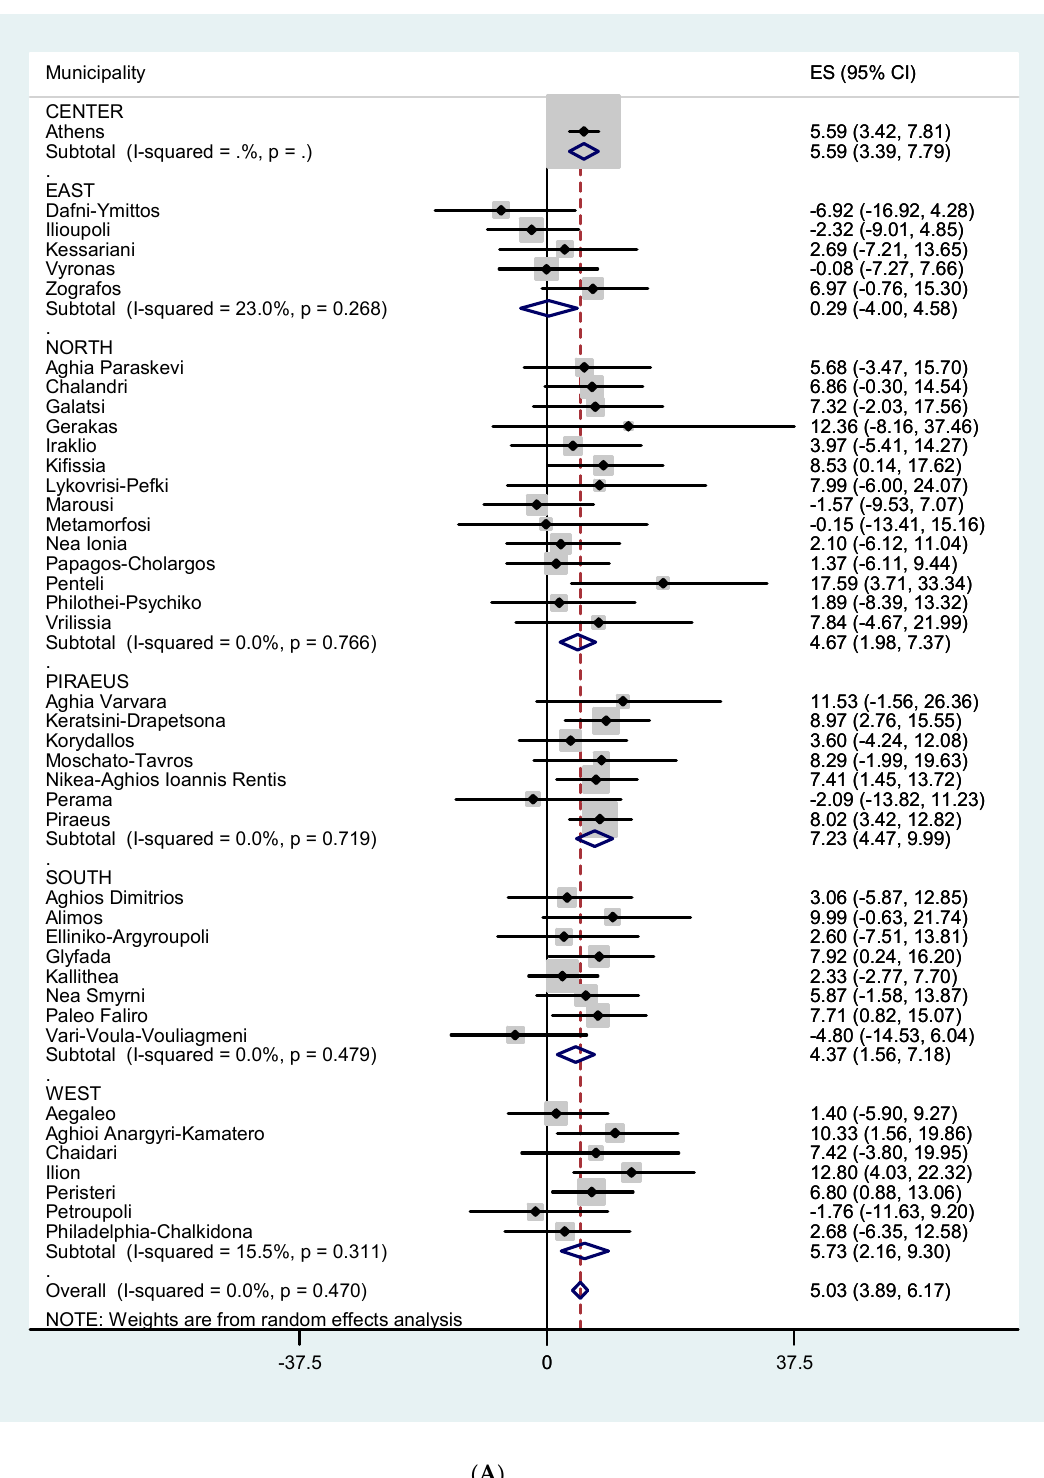
analysis. NOTE: Weights are from random effects Figure 5A.